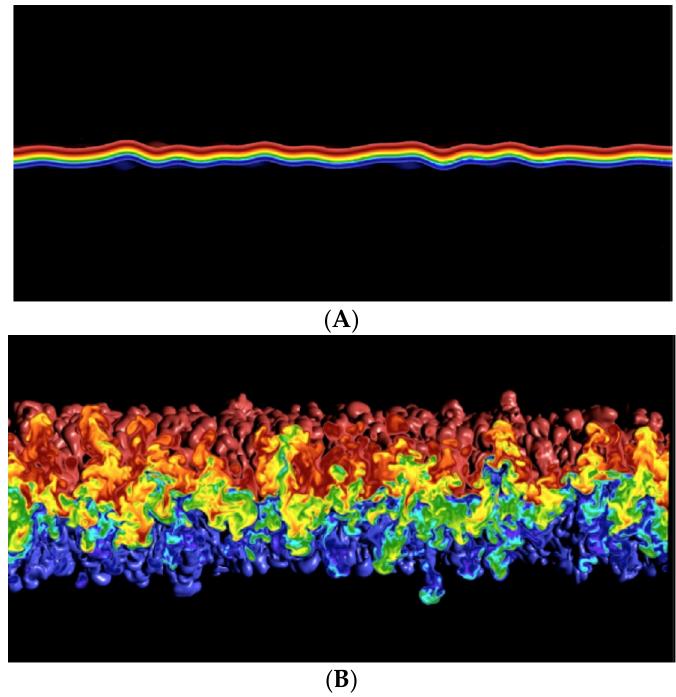
Figure 9. Snapshots of density field from DNS of RTI. Image proceeding were taken from video at t = 1 ( A ), t = 12 ( B ) [14].